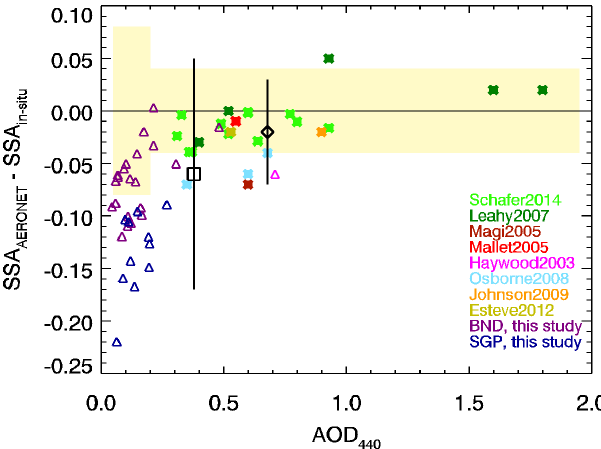
Figure 7. AOD 440 vs. [SSA AERONET − SSA INSITU ] for direct comparisons studies listed in Table 4. Open symbols are for SSA 440 difference; filled symbols are for SSA 550 difference. AOD 440 val- ues for Leahy2007, Osborne2008 and Johnson2009 use the Level 2 values reported on the AERONET web page for the locations and dates of the specific profile. Shading indicates the combined standard uncertainty of AERONET SSA values as function of AOD as reported in Table 4 of Dubovik et al. (2000) and uncertainty in the in situ SSA based on Fig. 2. The black square and black dia- mond with vertical black lines represent, respectively, the mean and 2 × standard deviation for all direct comparisons (including BND and SGP) and for literature direct comparisons